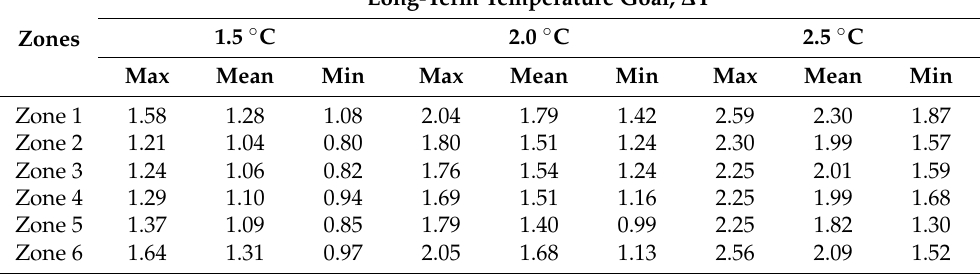
Table 4. Ensemble maximum, minimum, and mean change in annual temperature ( ◦ C) over the six sub-regions of the Caribbean for the three global warming thresholds. Changes are with respect to a 1960–1990